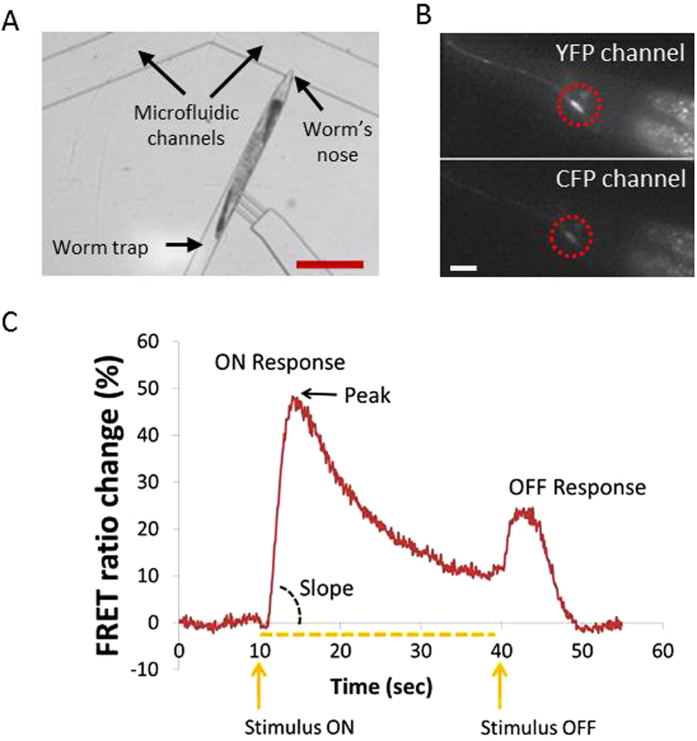
(A) The 4-flow microfluidic chip is used for immobilizing single worms and delivering a chemical stimulus (glycerol) to their nose21 to induce neuronal activation. Before and after the delivery of the stimulus, a control buffer solution is being delivered to the worm’s nose. Scale bar: 200 μm. (B) Fluorescence image of a trapped worm. The ASH neuron (highlighted by the dotted circle) is labelled with the FRET indicator TNXL. Top Image: YFP channel, bottom image: CFP channel, scale bar: 5 μm. (C) A typical Ca2+ transient response of the ASH neuron. The stimulus is delivered at 10 sec and removed at 40 sec. The maximum FRET ratio change upon delivery of the stimulus is considered as the “peak” response. The ASH neuron has a biphasic (ON/OFF) response21.